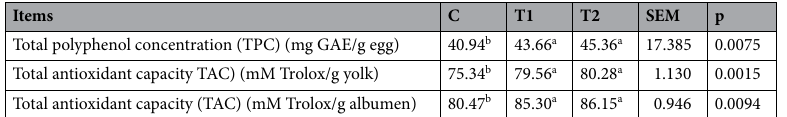
Table 4. Effect of dietary by-products on antioxidant compounds determined in eggs. C control diet, T1 control diet with 9% rapeseed meal and 3% grapeseed meal, T2 control diet with 9% flaxseed meal and 3% sea buckthorn meal, SEM standard error of the mean, p significance. ab Mean marked with a different superscript letter within each column are significantly different.